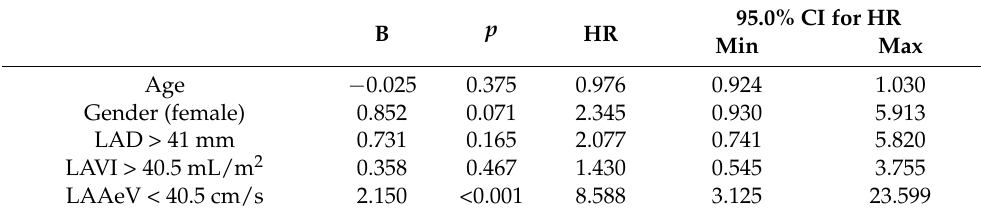
Table 5. Multivariate analysis for AF